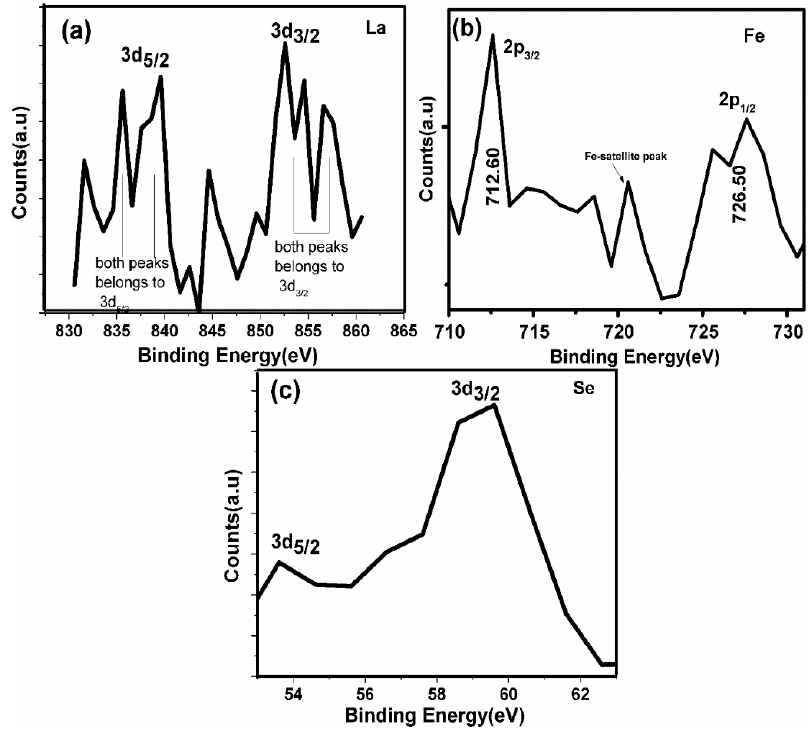
Figure 4. XPS high resolution spectra of the LBFSe50–G system extracted from survey scan (a) La-3d (b) Fe-2p and (c) Se-3d.